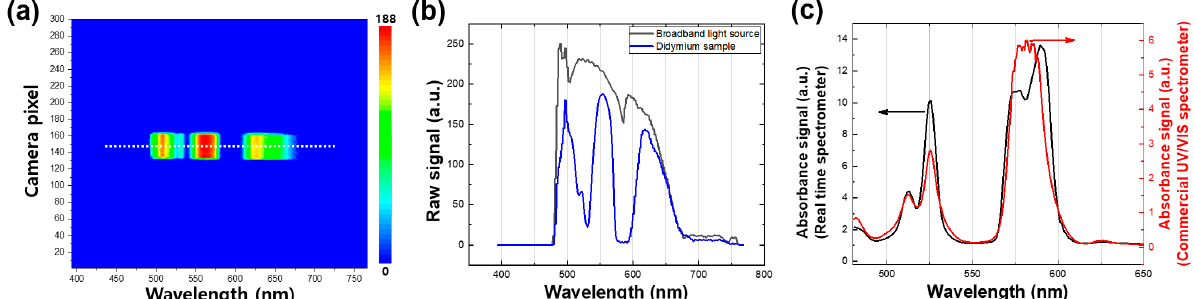
Figure 3. ( a ) A representative contour map of the broadband light source when the light passed through the didymium glass filter. ( b ) Emission spectra of the broadband light source (black) from the white line in Figure 2a. and the light source passed through the didymium sample (blue) from the white line in ( a ). ( c ) Absorbance spectrum of the didymium glass filter sample obtained by the real-time spectroscopy (black) and the spectrum obtained by the commercial UV/VIS spectroscopy (red).